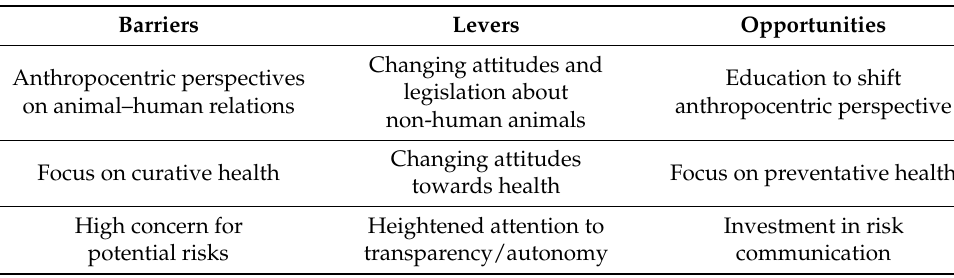
Table 3. Barriers, levers, and opportunities at the landscape